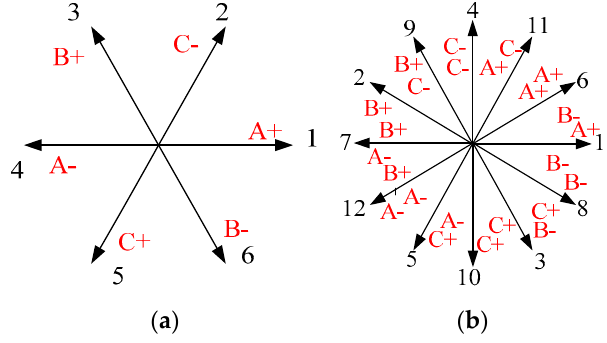
Figure 4. Star of slots: ( a ) Q48p8, ( b ) Q36p15. After the physical distribution of the conductors is obtained, the winding factor, current unit can be calculated using (28) and (29).